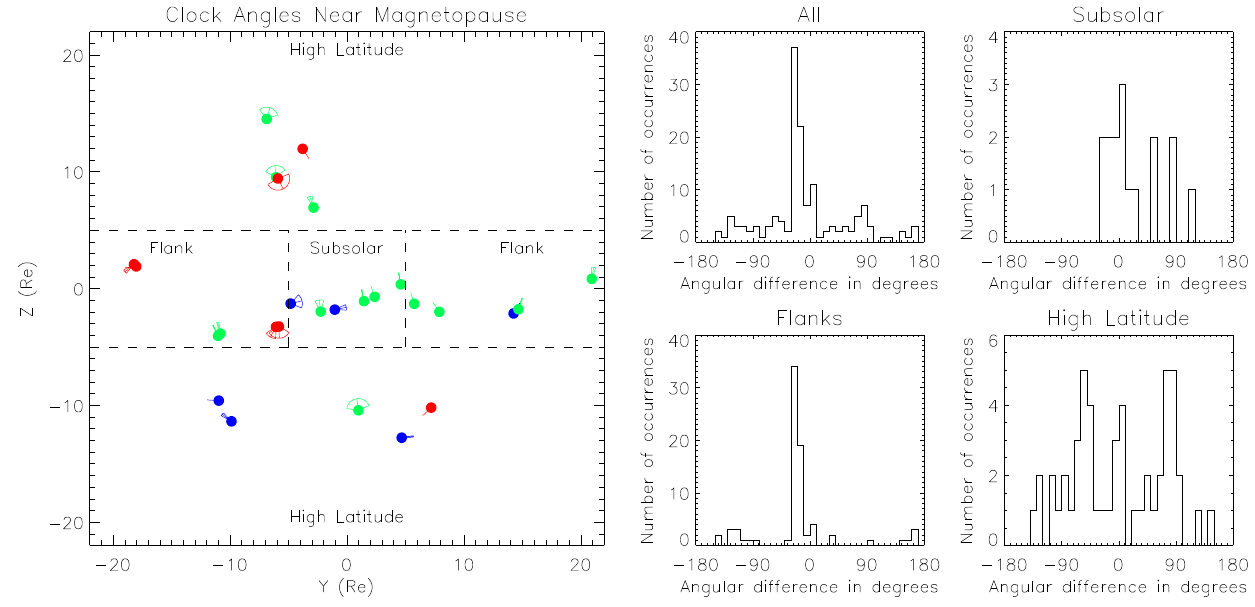
Fig. 4. Clock angles measured near magnetopause, and angular differences from perfect draping, for Northward IMF. Format as Fig.